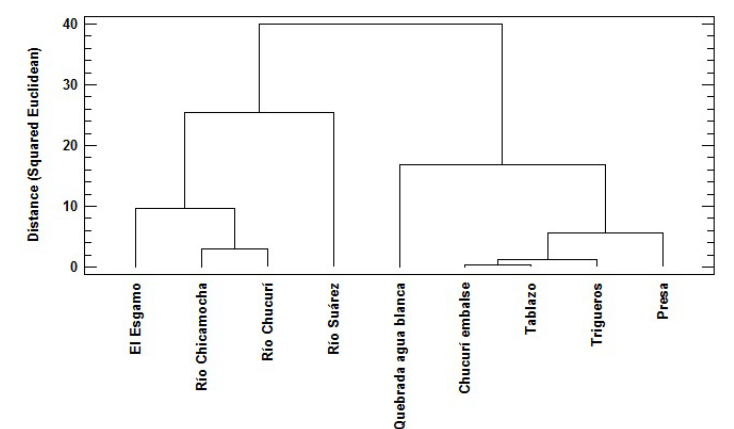
Figure 2. The dendogram shows the result of clustering the n = 9 sampling stations in the Hidrosogamoso reservoir using Ward’s method and squared Euclidian distance. El Esgamo, Río Chicamocha, Río Chucurí and Río Suárez stations forms a first cluster separate from the second one formed by Quebrada agua blanca, Chucurí embalse, Tablazo, Trigueros and Presa stations. The firts one located at the peripheria and the second one near the center of the reservoir. Table 7. Classification Table for the two groups from cluster analysis. Each row tabulates the results for cases that actually belong to a particular group and the columns show how often they were classified as belonging to each group. The percentage of cases correctly classified is 100%.